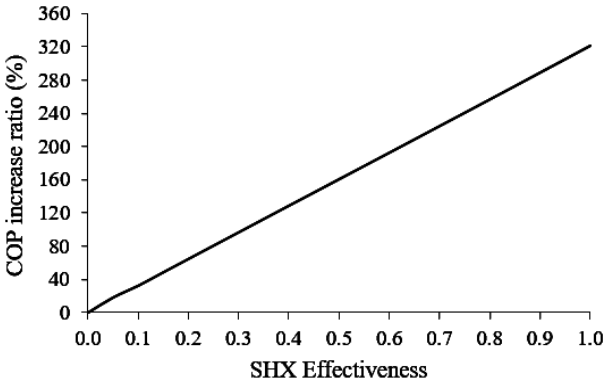
Figure 31. COP increase ratio as a function of ε SHX .